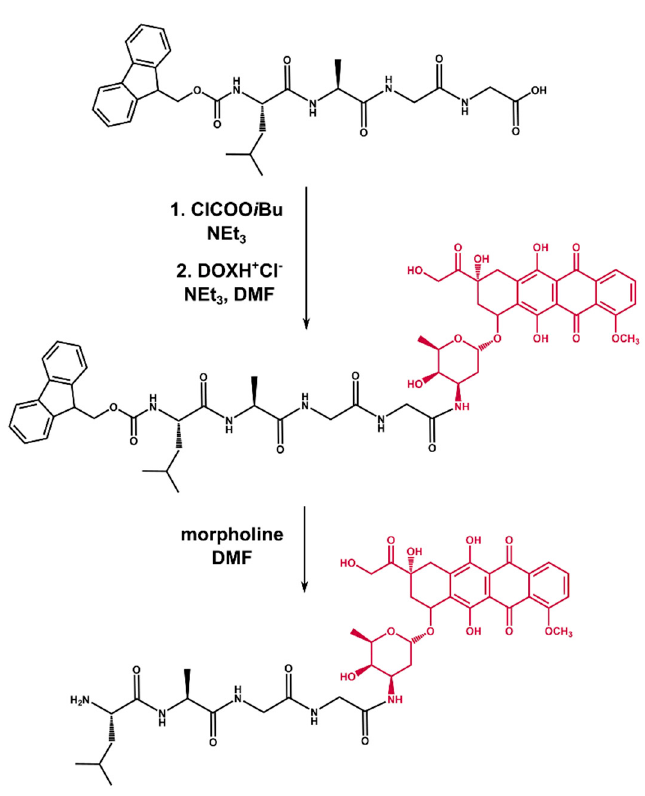
Figure 3. Synthesis scheme of the Leu–Ala–Gly–Gly–DOX conjugate.